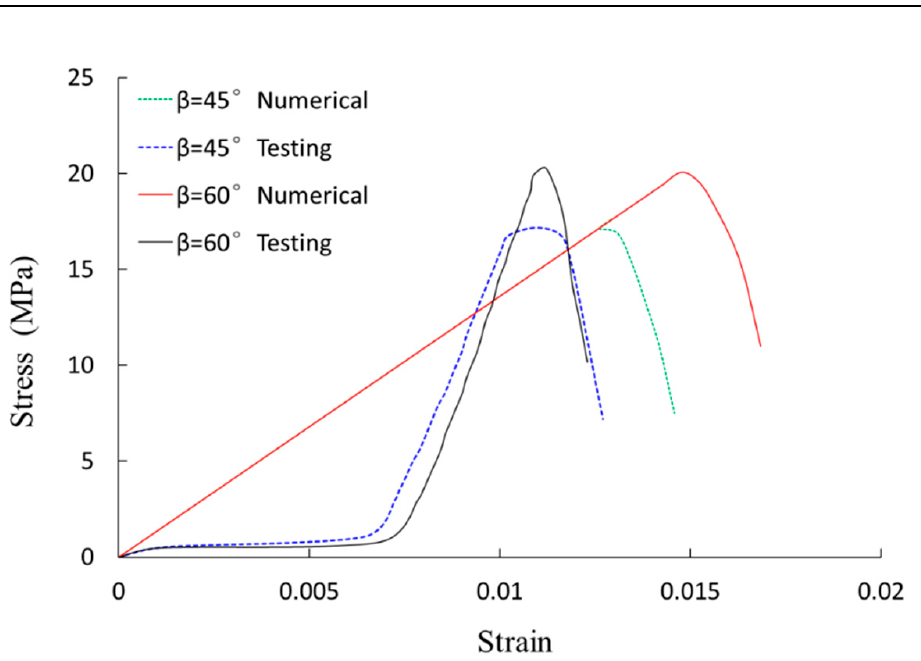
Figure 6. Stress–strain curves under numerical and experimental results (crack width = 3.0 mm).